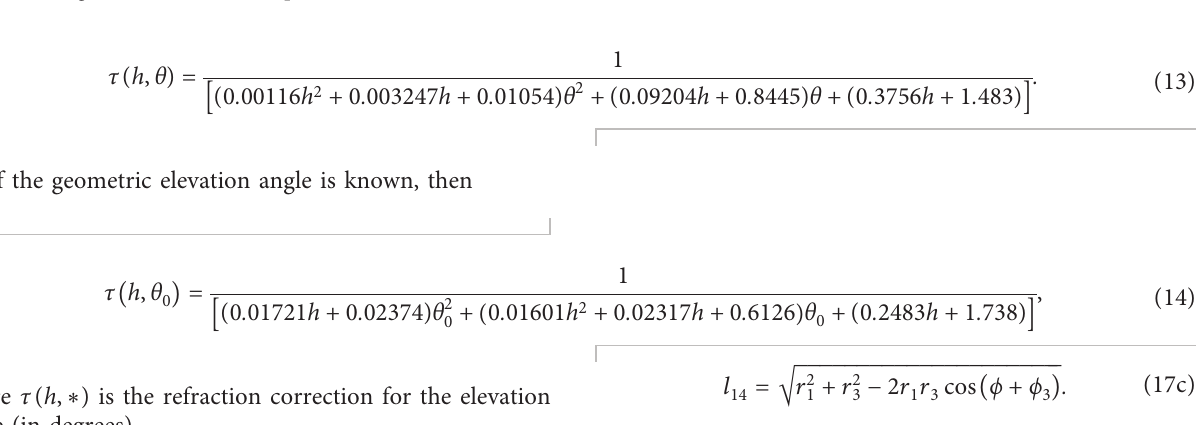
Figure 2: Elevation angle errors of two different calculations for the mean annual global reference atmosphere.